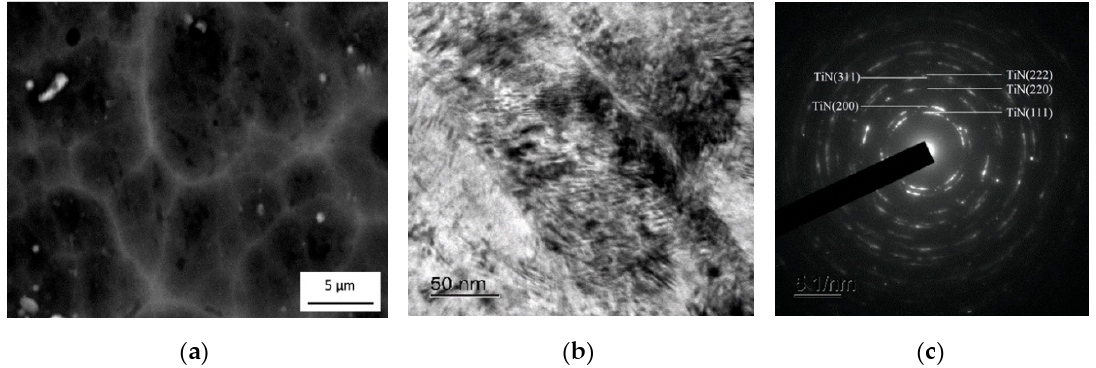
Figure 3. SEM images of surface, ( a ) high-resolution electron microscopic images of the coating